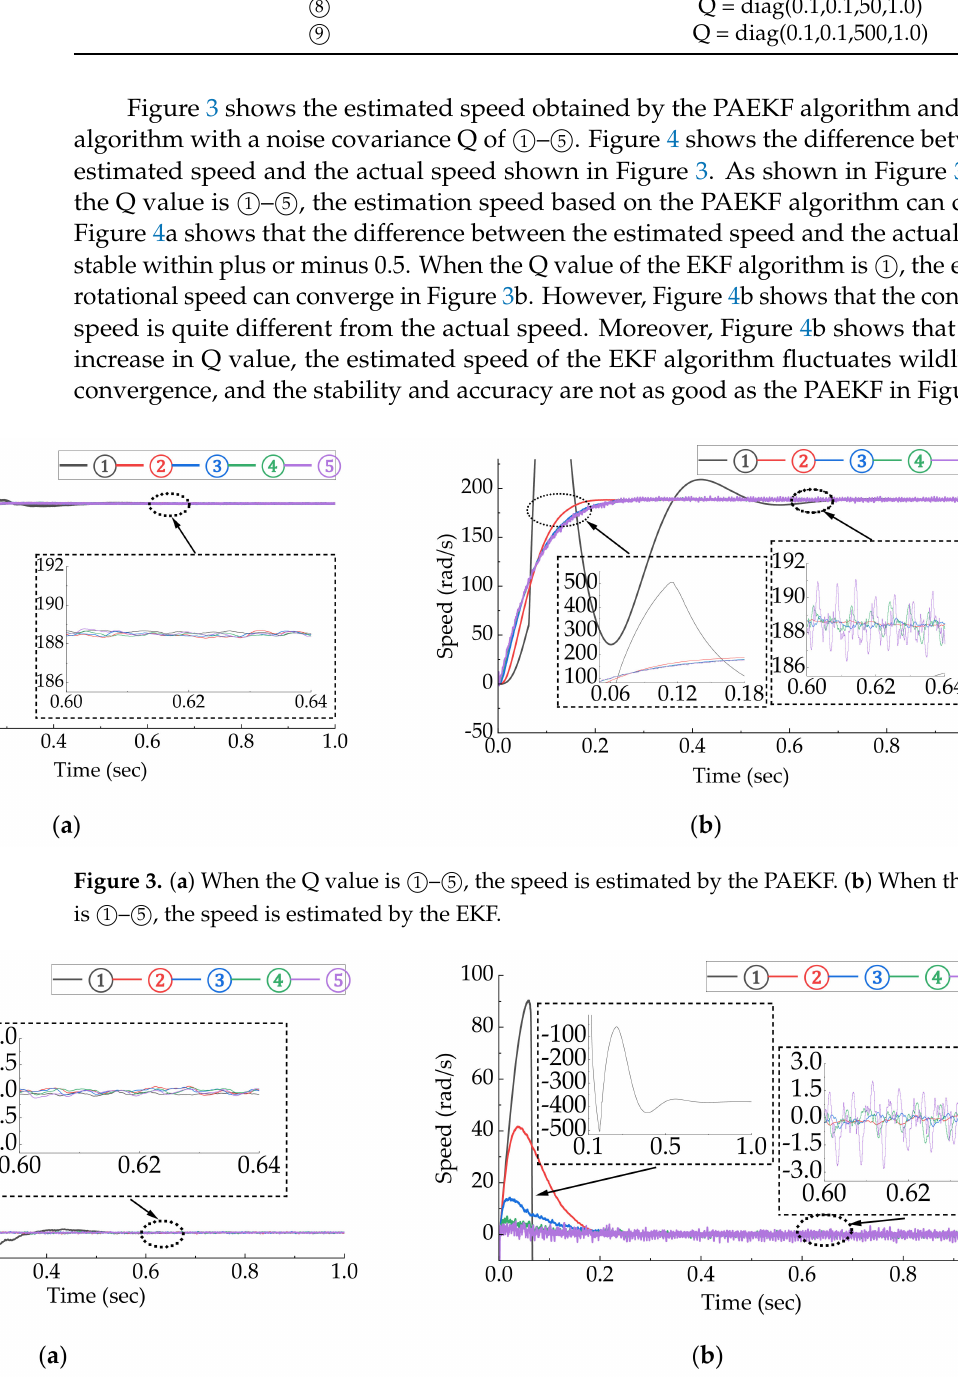
Figure 4. ( a ) When the Q value is 1 (cid:13) – 5 (cid:13) , the difference between actual speed and estimated speed based on PAEKF. ( b ) When the Q value is 1 (cid:13) – 5 (cid:13) , the difference between actual speed and estimated speed based on